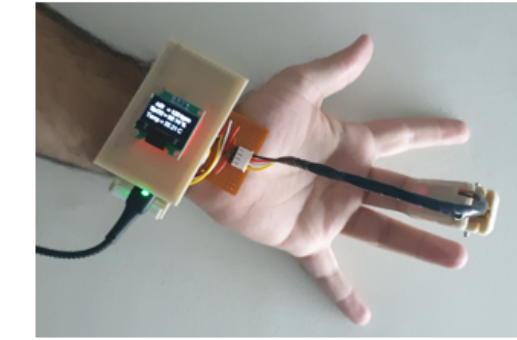
Figure 5. 3D printed models of the wearable watch and oximeter.